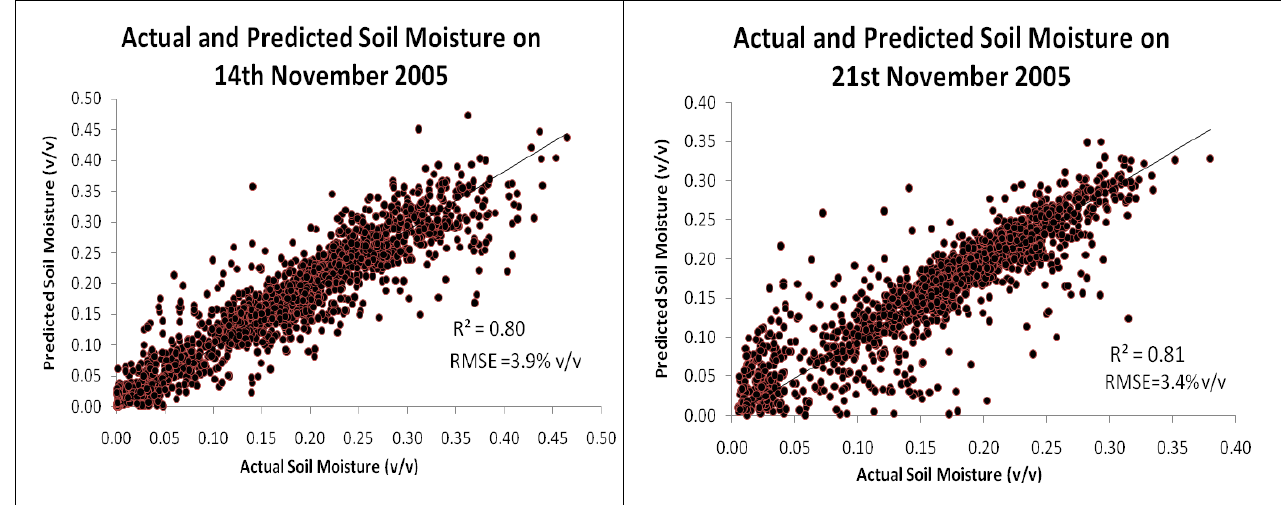
Figure 6 . Relationships between referenced and predicted soil moisture value on 14 and 21 November